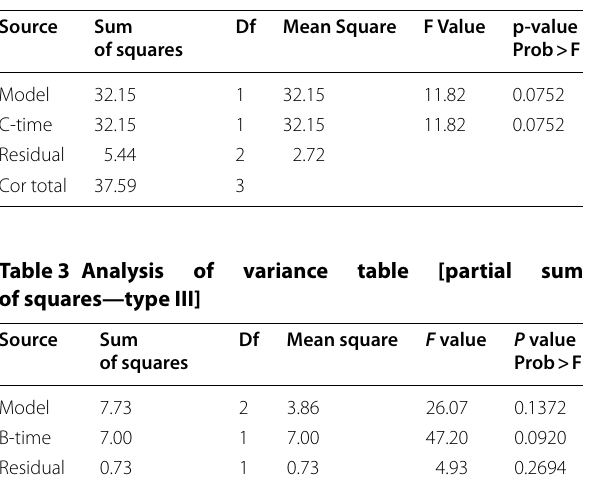
Table 2 Analysis of variance [partial sum of